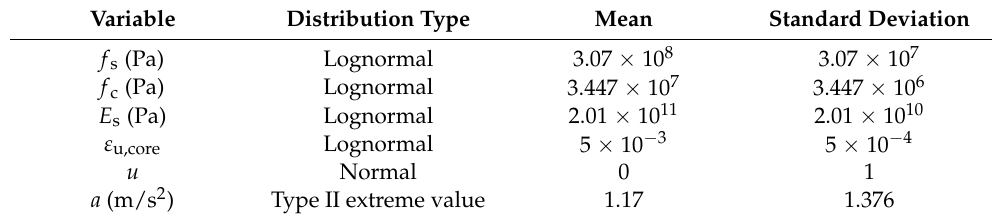
Table 5. Random parameters in Example 2.